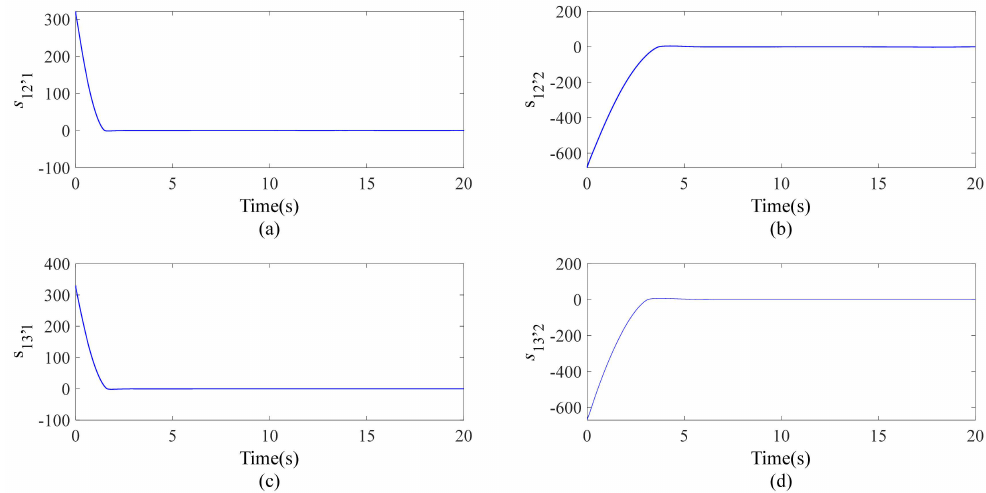
Figure 7. Sliding surfaces of the two followers. ( a ) s 12,1 , ( b ) s 12,2 , ( c ) s 13,1 , ( d ) s 13,2 .